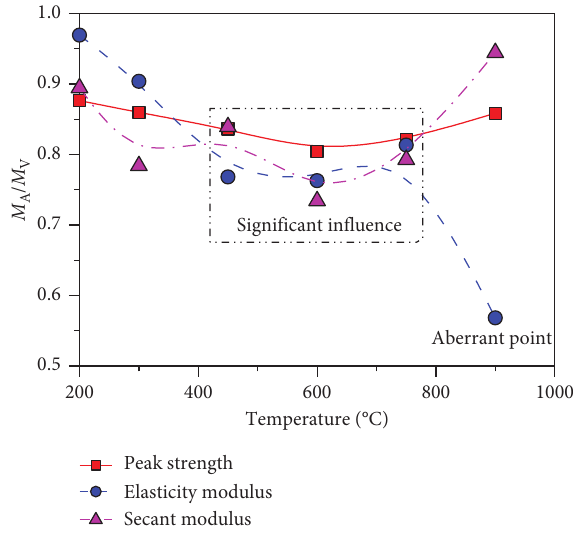
Figure 6: Variation in ( M ) A /( M ) V with different